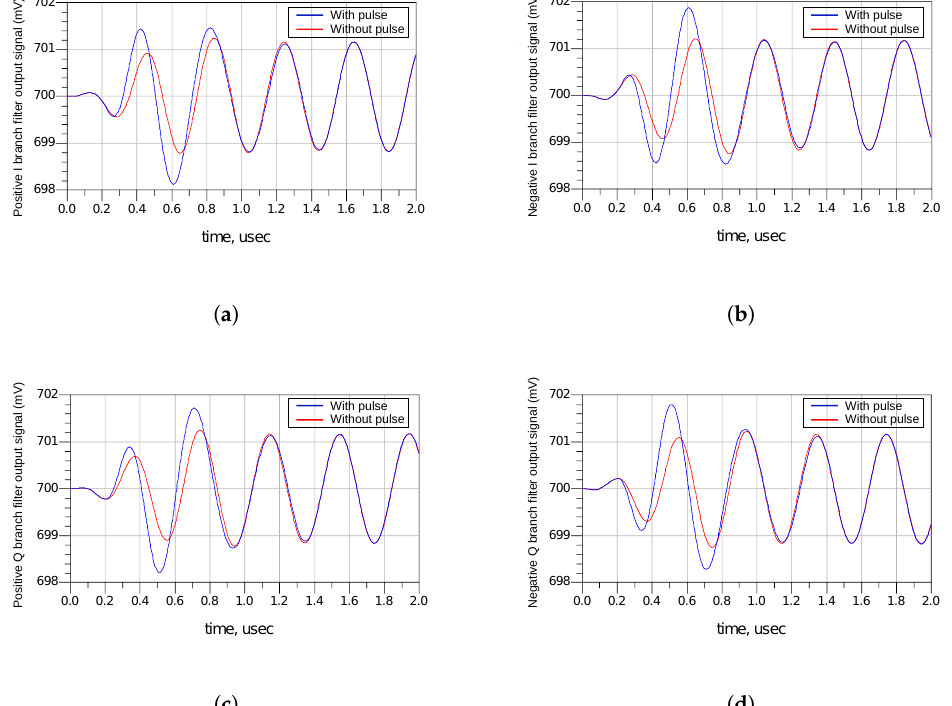
Figure 15. Output signals of the complex filter: ( a ) positive I branch, ( b ) negative I branch, ( c ) positive Q branch and ( d ) negative Q